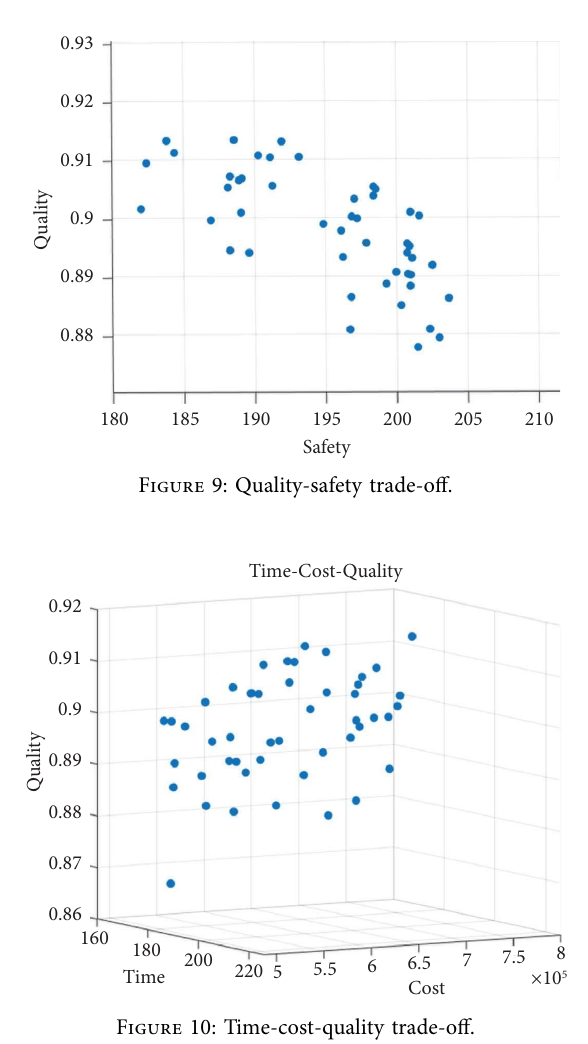
Figure 13: Quality-safety-time